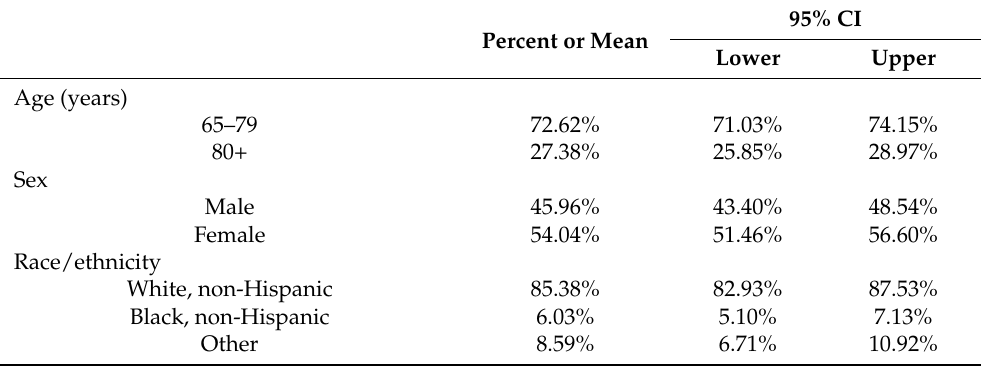
Table 1. Characteristics of study participants (sample n = 2628; population n =